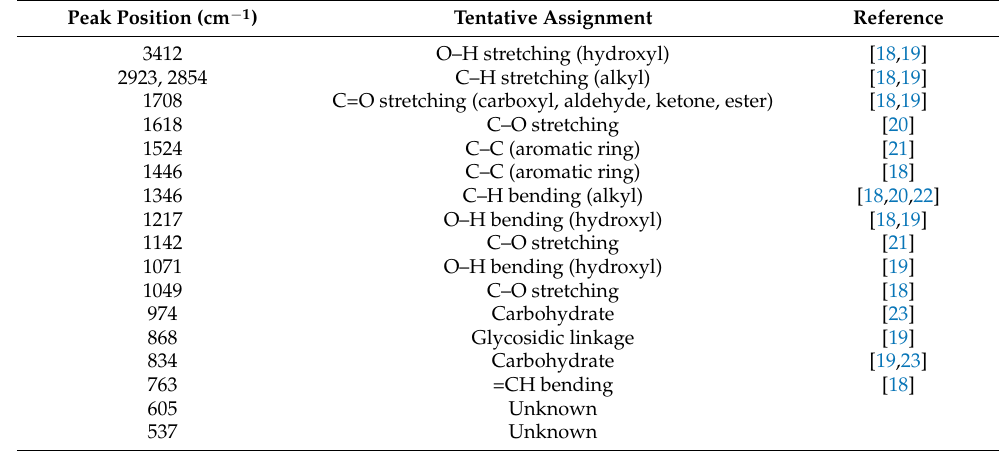
Table 2. Peak position (cm − 1 ) and tentative assignments of FT-IR absorbance bands for RPE recorded in the spectral region from 500 to 3500 cm − 1 .